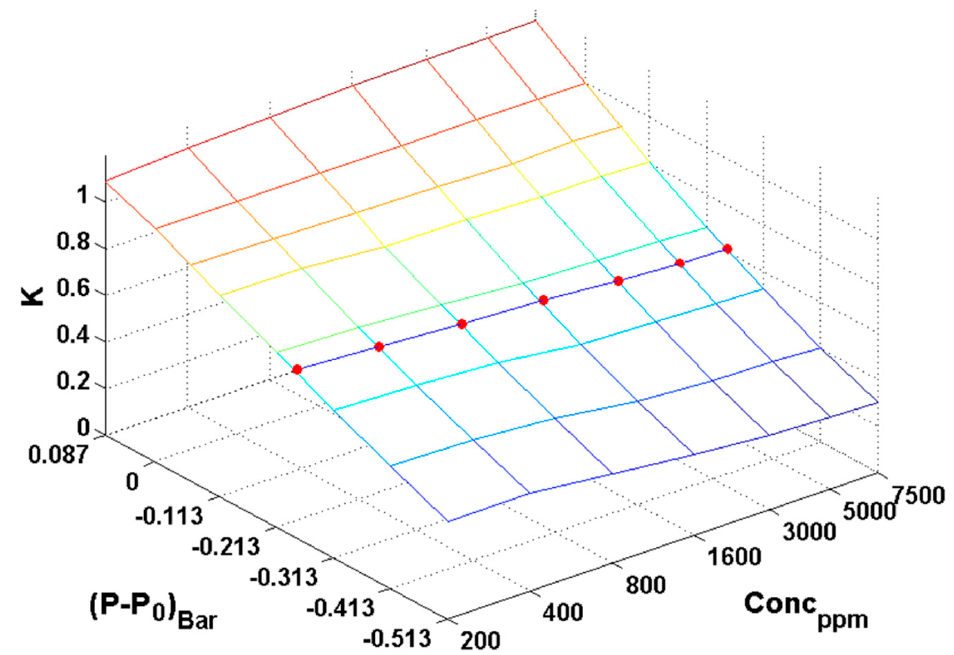
Figure 5. Space of compensation factor values in 3D volume concentration range vs. pressure range vs. compensation factor range. Red dots indicates K values for different reference concentrations on the same certain pressure level.